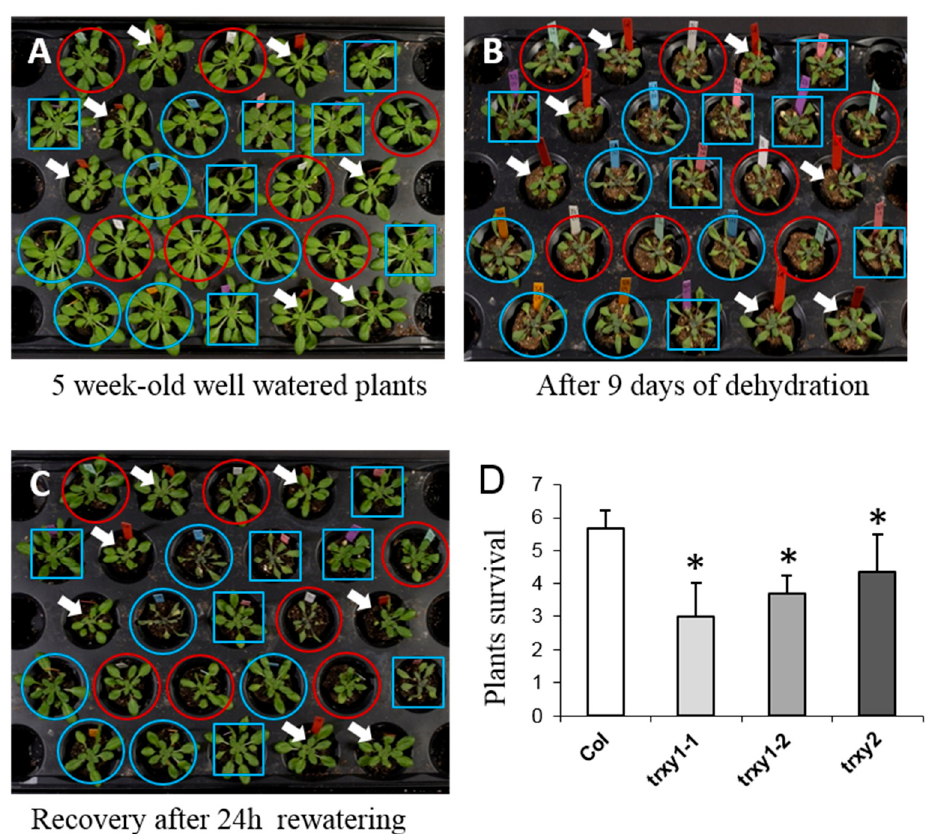
Figure 1. Water stress tolerance of WT and trxy mutant plants. After 3 weeks of growth under ( A ) standard conditions; ( B ) plants watering was stopped for 9 days and then ( C ) rehydrated for 24 h before ( D ) plant survival was monitored. Data correspond to means ± SD ( n = 6). The asterisk (*) indicates a mutant sample significantly different from wild-type ( p < 0.05). White arrows, blue circles, blue squares and red circles indicate wild-type (Col), trxy1-1 , trxy1-2 and trxy2 plants, respectively.